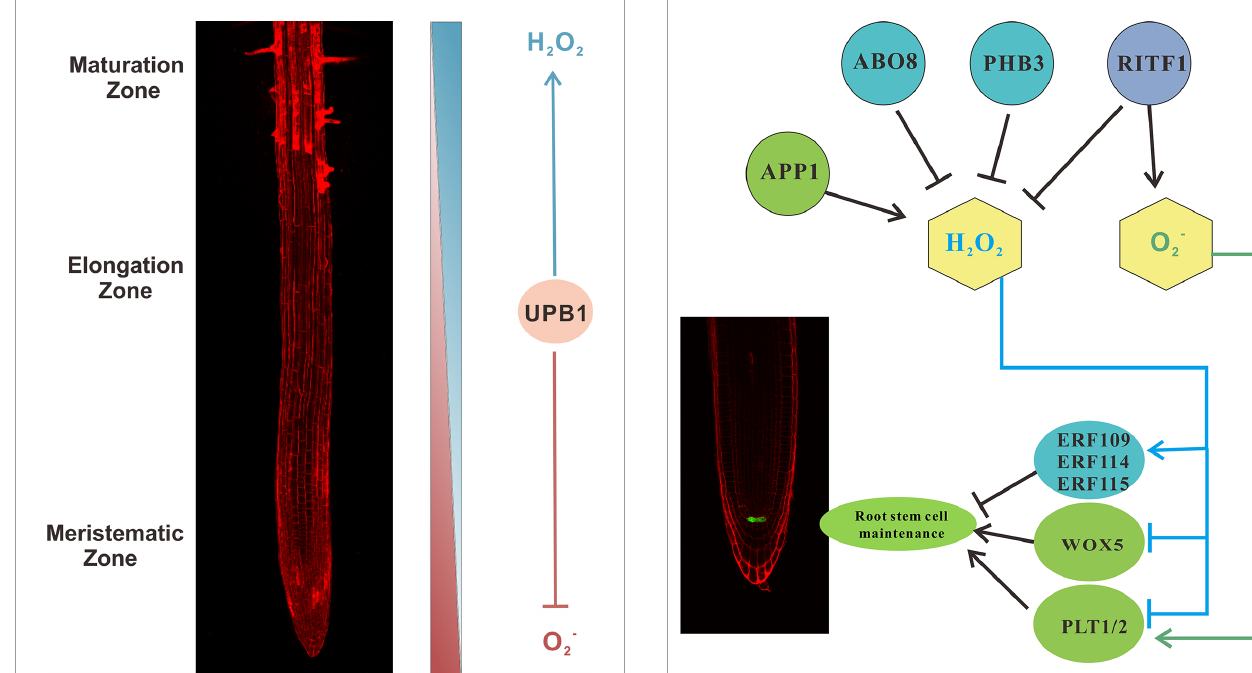
FIGURE 1 | Gradient distribution of superoxide anion (O 2 (cid:129) − ) and hydrogen peroxide (H 2 O 2 ) in Arabidopsis thaliana roots. Nitro blue tetrazolium (NBT) staining showed the distribution of O 2 (cid:129) − in the roots, from the meristematic to elongation zones. The gradients of reactive oxygen species (ROS) are regulated by peroxidases, which are modulated by the UPBEAT1 (UPB1) factor. The concentration of O 2 (cid:129) − decreases along a gradient from the meristem to transition zones and the concentration of H 2 O 2 decreases along a gradient from the differentiation to elongation zones. Arrow-head line indicates stimulation effect, and “ T ” -shaped line shows the inhibition.